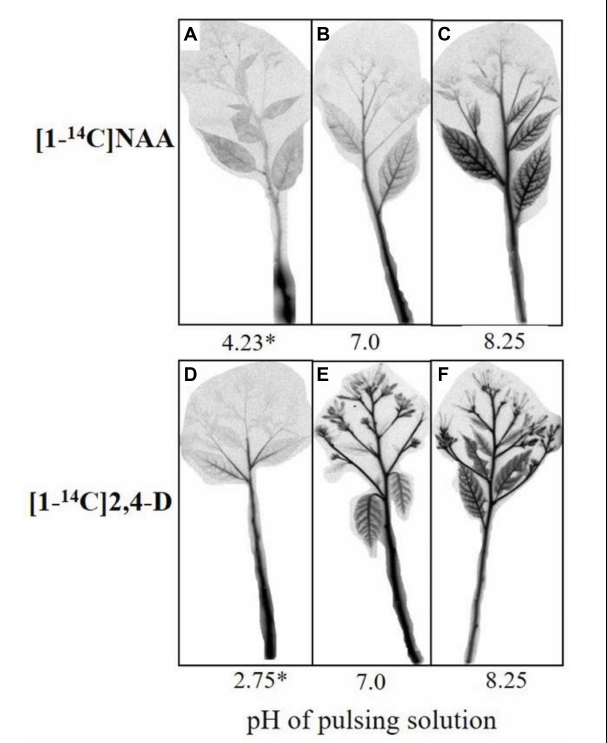
FIGURE 3 | Autoradiography images of the acropetal transport of labeled NAA (A–C) or 2,4-D (D–F) in Red Cestrum cut flowers after pulsing at different pH levels. The cut flowers were pulsed for 24 h at 20 ◦ C with either 0.2 mM NAA or 2,4-D containing radiolabeled standards, at the indicated pH values. After pulsing the shoots were dried and exposed to a Fujifilm Imaging Plate for 48 h. Asterisk, the pH = pKa values of each